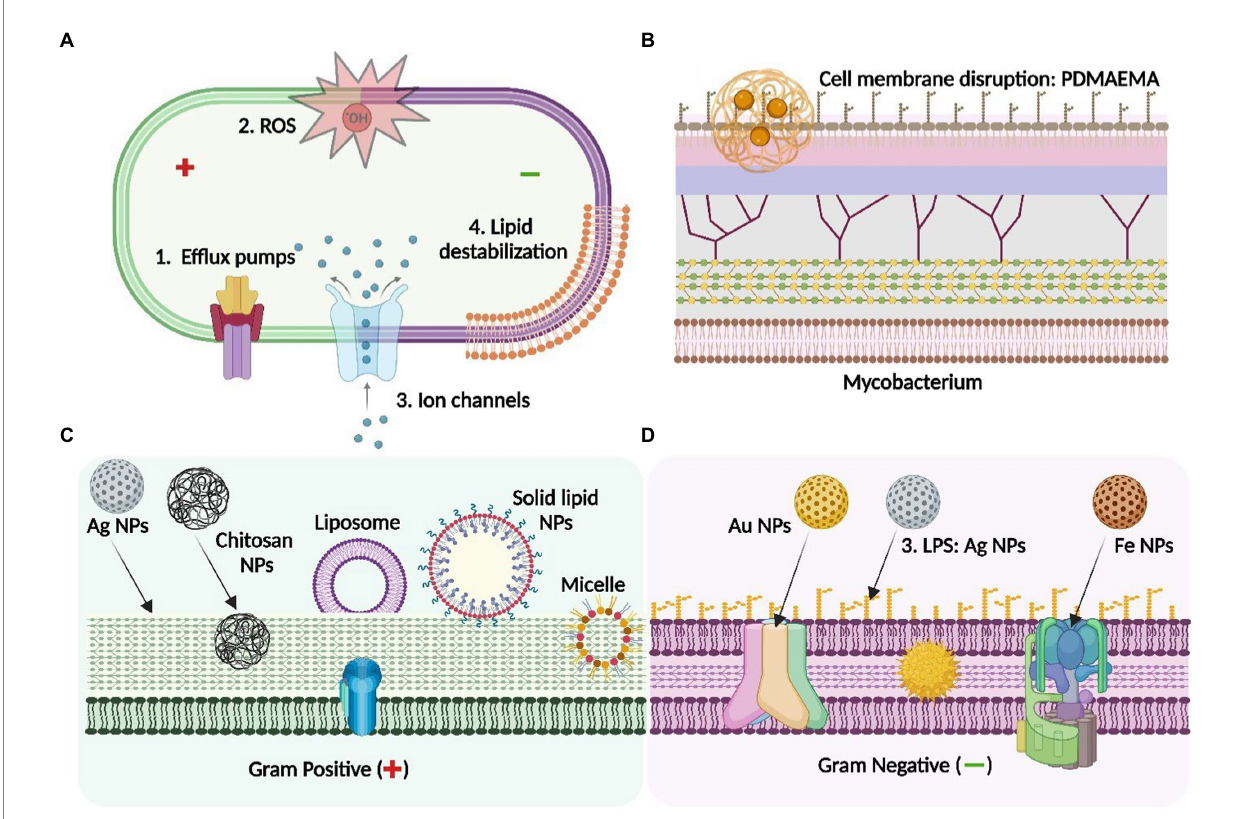
FIGURE 2 Antibacterial mechanisms of different class of nanoparticle: Mechanistic insight into the nanoparticle interaction with bacterial membrane to overcome AMR. (A) depicts the general membrane targets of the NPs through the activity of efflux pumps, reactive oxygen species (ROS), ion channels and membrane lipid destabilisation serving as antibacterial agents: (B) depicts the mycobacterial membrane and the interaction of PDMAEMA [poly(dimethylaminoethyl) methacrylate] polymeric NPs with the LPS layer of the mycobacterium, leading to cell membrane disruption; (C) represents the precise membrane interaction of the NPs with the Gram- negative bacteria- Ag NPs interact with LPS whereas AuNPs and Fe NPs binds with different targets through specific membrane transport proteins including the porin channels and the F0-F1 ATPase respectively; (D) shows the specific targets of different types of NPs on the Gram-positive bacterial membrane-Ag NPs, chitosan (polymeric) NPs, solid-lipid NPs: These interact with peptidoglycan layer of the cell envelop to exert antimicrobial activity. Others, including micelle or liposome-based NPs serves as a carrier to enhance the penetration of the antibiotic by interacting with the thick peptidoglycan of the bacterial membrane. Figure created in